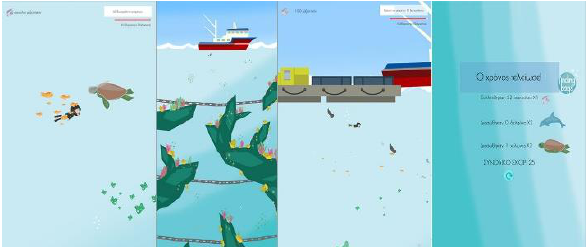
Figure 2. Screenshots of the game “Finding